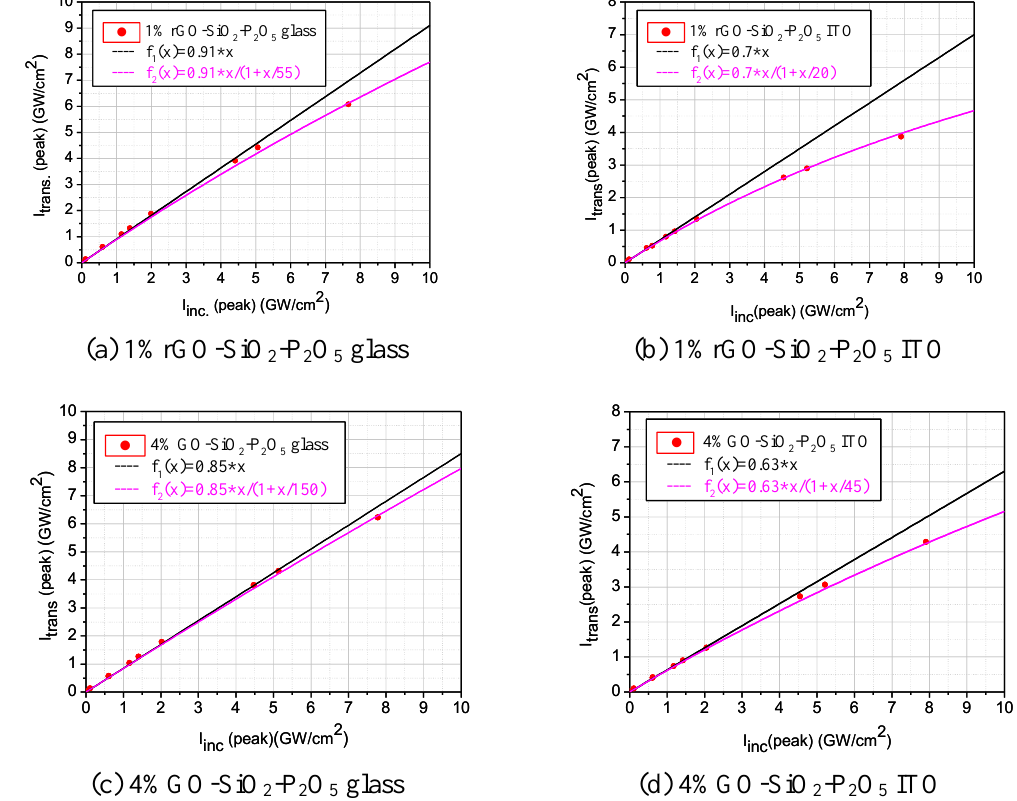
Figure 18. The transmitted peak intensities vs. incident ones for two sets of corresponding composite samples: with rGO deposited on glass ( a ) and on ITO-coated glass ( b ); with GO deposited on glass ( c ) and on ITO-coated glass ( d ).